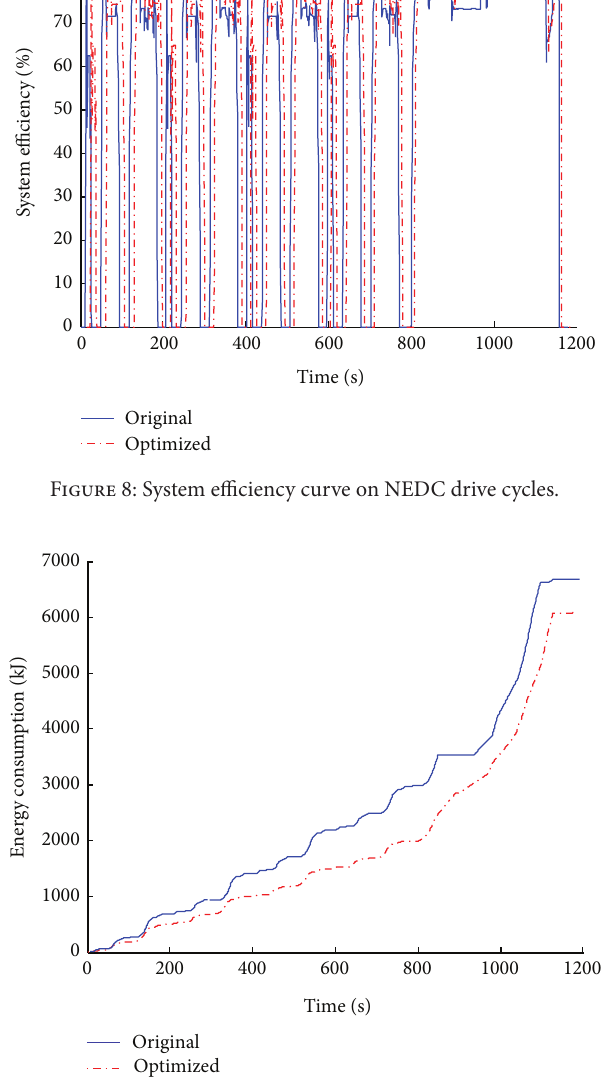
Figure 9: Energy consumption curve on NEDC drive cycles.